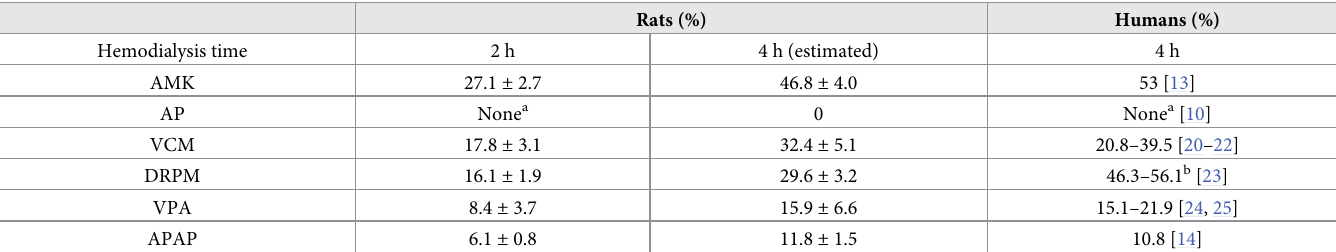
Table 3. Comparison of drug removal of various drugs between humans and in vivo rat model. Rats (%) Humans (%) Hemodialysis time 2